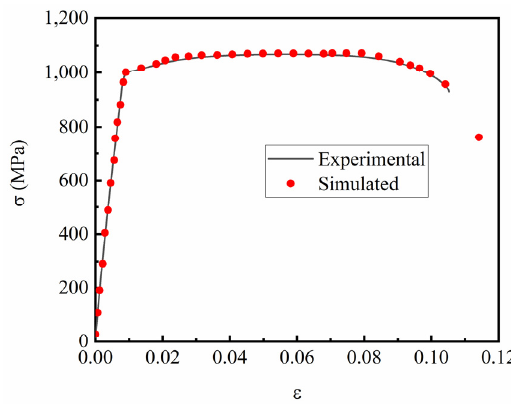
Figure 14. Comparison of stress–strain curves from the test and simulation. Materials 2022 , 15 , x FOR PEER REVIEW